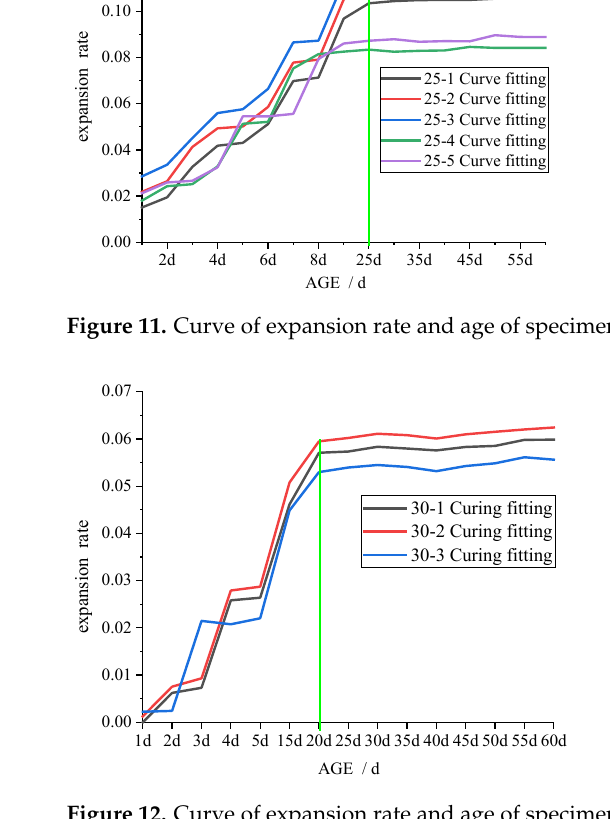
Figure 12. Curve of expansion rate and age of specimen with 30% binder.